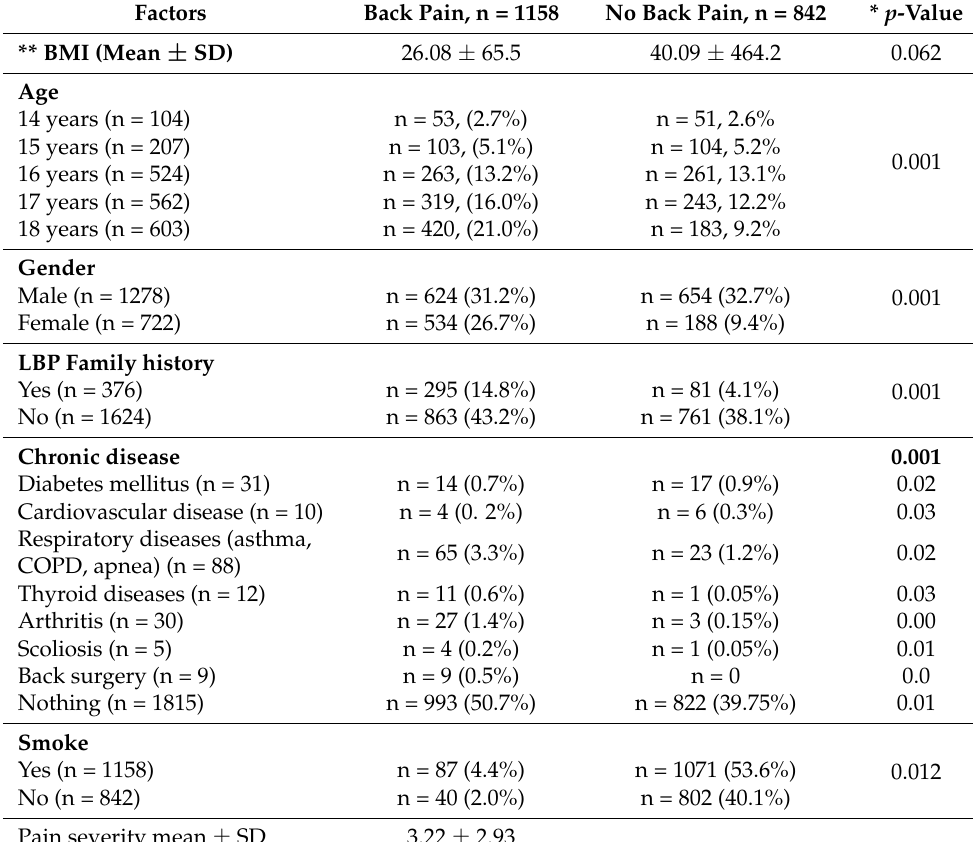
Table 2. Demographics and clinical characteristics of